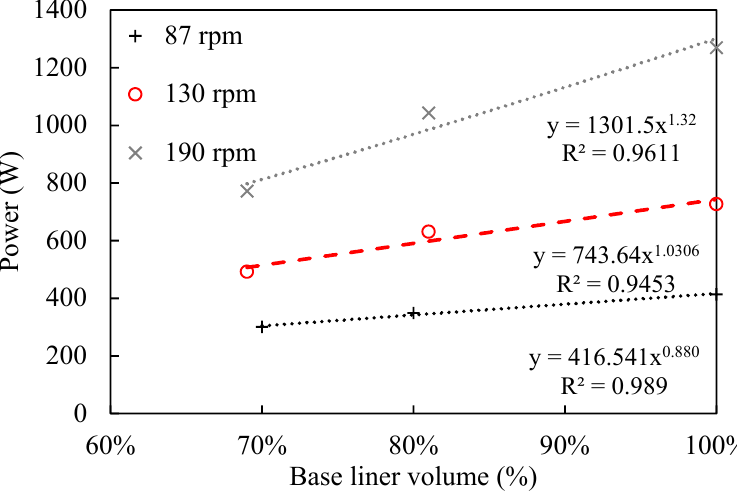
Figure 16. the relationship between simulation power and base liner volume.